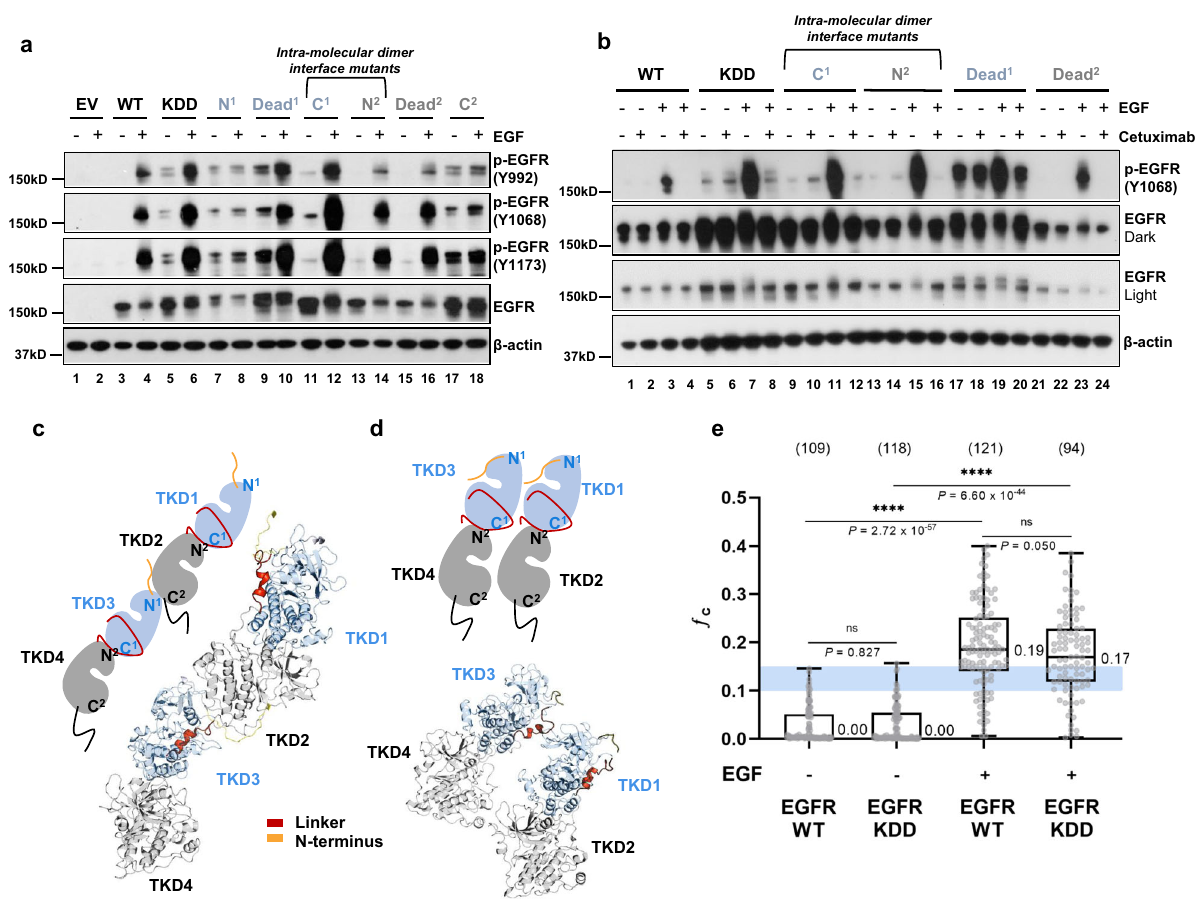
Fig. 3 EGFR-KDD forms inter-molecular dimers and higher order oligomers after ligand stimulation. a YAMC cells were cultured in serum-free medium for 12 h and then treated with 50 ng/mL EGF ligand for 5 min. Total EGFR and the autophosphorylation at three tyrosine sites were assessed by western blot. b YAMC cells were starved for 12 h and treated with cetuximab (10 µ g/ml in serum-free medium) for 3 h 45 min, and EGF ligand (50 ng/mL in serum- free medium) was added for 15 min. The cells were harvested and analyzed by Western blot. WT, EGFR-WT; KDD, EGFR-KDD. c Template-based structural models of the intracellular portion of the EGFR-KDD inter-molecular dimer based on end-to-end EGFR-WT tetramer models. d Template-based structural models of EGFR-KDD inter-molecular dimer based on side-by-side EGFR-WT tetramer model. e Cross-correlation values of EGFR-WT and EGFR- KDD with ( + ) or without ( − ) ligand (EGF) stimulation is shown. The blue box indicates the ƒ c value region for dimers. For the box and whiskers plot, the whiskers show the maximum and the minimum; the box shows 25th – 75th percentile; and the line in the box is the median value. The median values are reported next to the boxplot. Each gray dot represents the averaged acquisition (10 s, 6 acquisitions) per area per cell. All data points are shown. Numbers in parenthesis above the boxplot are the total number of cells that data were taken on. For a and b , n = 3 experiments were repeated independently with similar results. Results are the representative of three independent experiments. For e , one-way ANOVA test with uncorrected Fisher ’ s LSD post hoc test were performed to obtain adjusted and individual P values. Data are presented as median values ± SD. For a , b and e , source data are provided in the Source Data fi